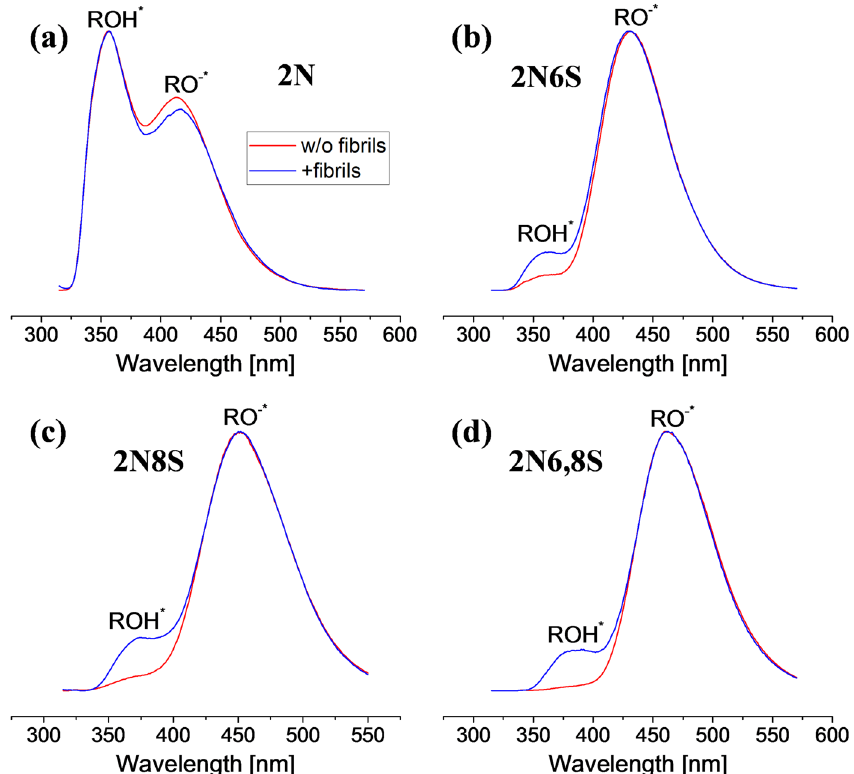
Figure 2. Normalized steady-state fluorescence of the different photoacids: ( a ) 2N, ( b ) 2N6S, ( c ) 2N8S and ( d ) 2N6,8S, in pH7 buffer (red curves), and in the same buffer with insulin fibrils (blue